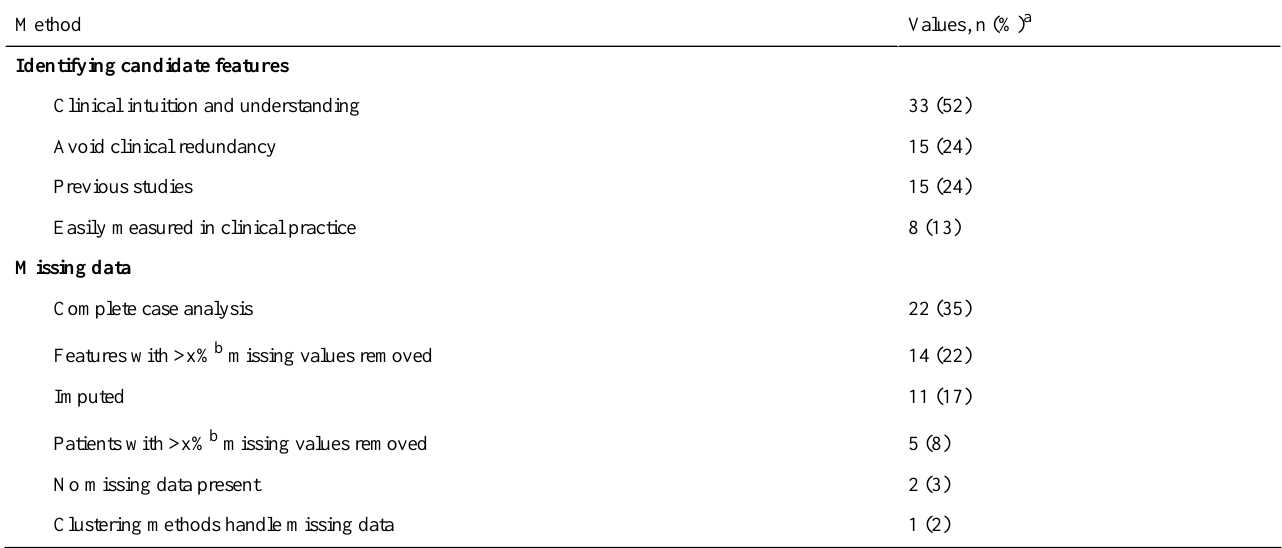
Table 1. Initial considerations across the asthma studies we have included in this review (N=63).